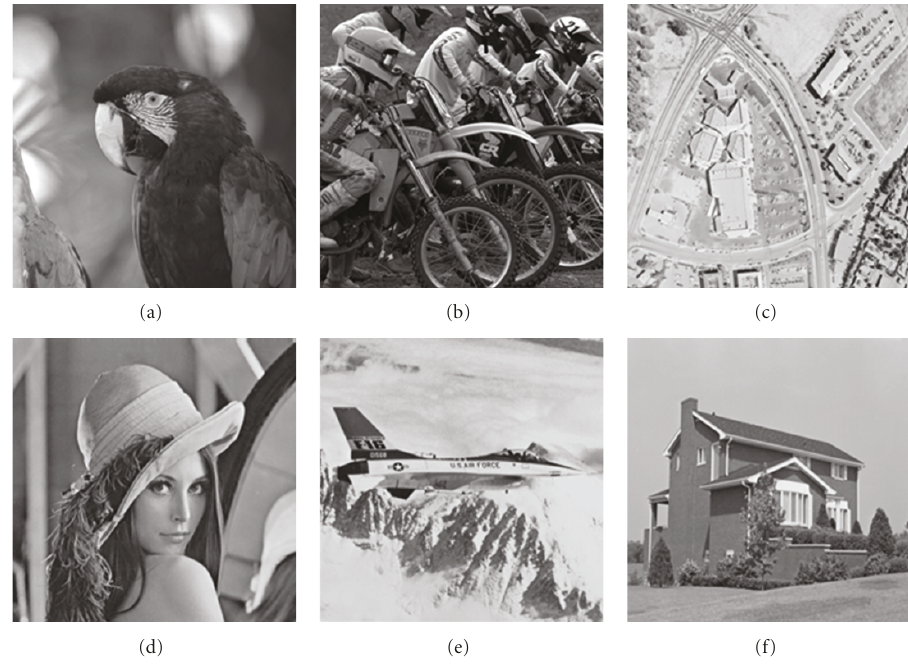
Figure 9: Six natural images in the test set. (a) Parrot; (b) Bike; (c) Aerial; (d) Lena; (e) Airplane; (f)